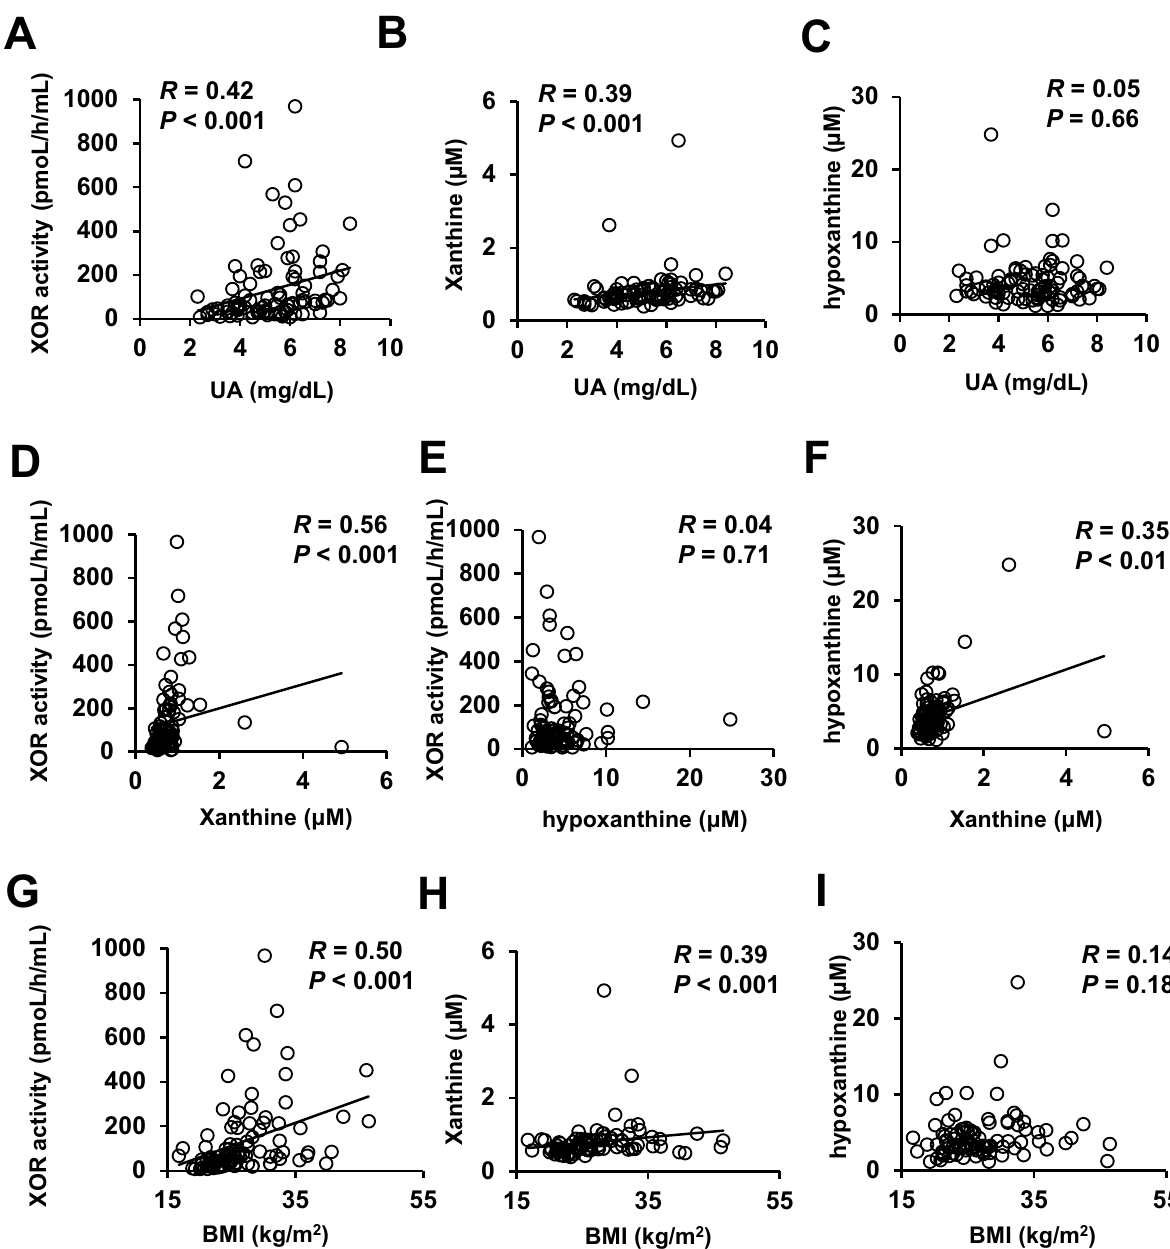
Figure 1. Correlations among the plasma XOR activity and plasma levels of xanthine and hypoxanthine. ( A ) Correlation between the plasma XOR activity (pmol/h/mL) and serum uric acid level. ( B ) Correlation between the plasma xanthine concentration (µM) and serum uric acid level (mg/dL). ( C ) Correlation between the plasma hypoxanthine concentration (µM) and serum uric acid level (mg/dL). ( D ) Correlation between the plasma XOR activity (pmol/h/mL) and plasma xanthine concentration (µM). ( E ) Correlation between the plasma XOR activity (pmol/h/mL) and plasma hypoxanthine concentration (µM). ( F ) Correlation between the plasma xanthine concentration (µM) and plasma hypoxanthine concentration (µM). ( G ) Correlation between the plasma XOR activity (pmol/h/mL) and BMI (kg/m 2 ). ( H ) Correlation between the plasma xanthine concentration (µM) and BMI (kg/m 2 ). ( I ) Correlation between the plasma hypoxanthine concentration (µM) and BMI (kg/m 2